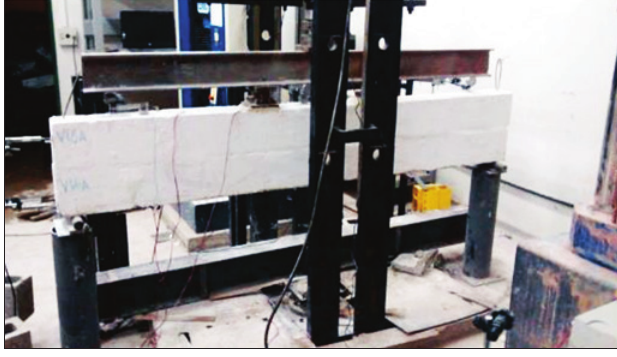
Beam ready to be tested